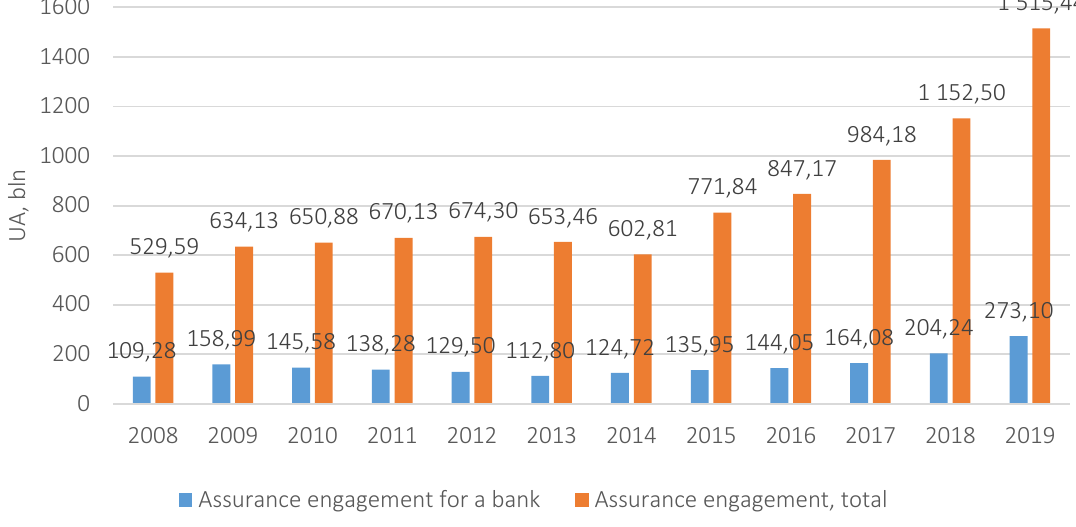
Figure 1. The volume of tasks providing confidence in businesses in all sectors of the economy and financial sector of Ukraine, 2008–2019, UAH mln, excluding VAT